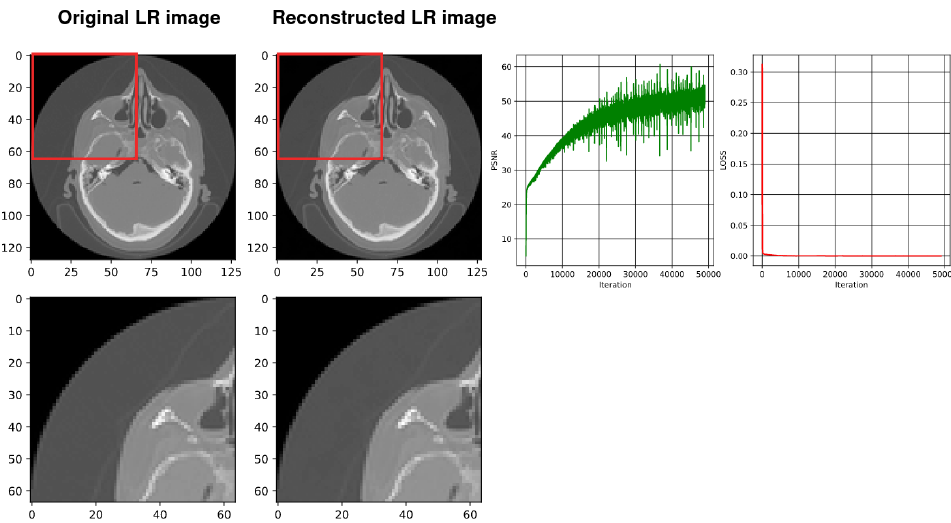
Figure 5. From the left, the first image shows the original down-sampled image. The second image illustrates the reconstructed counterpart of the down-sampled image using SIREN. The next image shows the plot of the PSNR while training the network (best PSNR: 48.29) and the last image shows the plot of the loss values during the SIREN training (loss: 1.0805471 × 10 − 5 ). Table 4. Shows comparison results of the implementation of SIREN with our architecture in terms of quality, speed, GPU memory allocation, and compression rate with 2, 3, and 4 layers of SIREN. Number